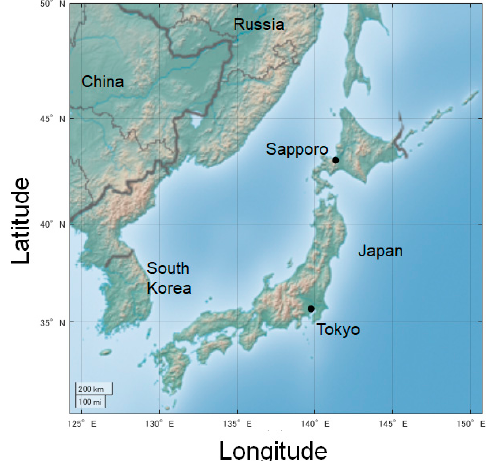
Figure 1. Topographic map of Japan showing Sapporo and Tokyo, the cities analyzed in this study.